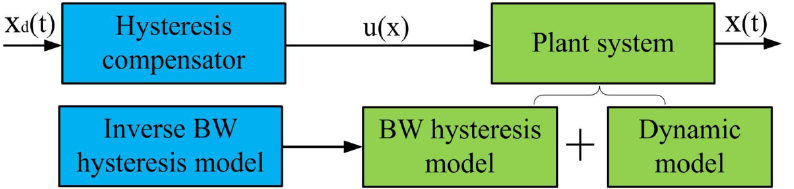
Figure 4. The principle to compensate hysteresis.